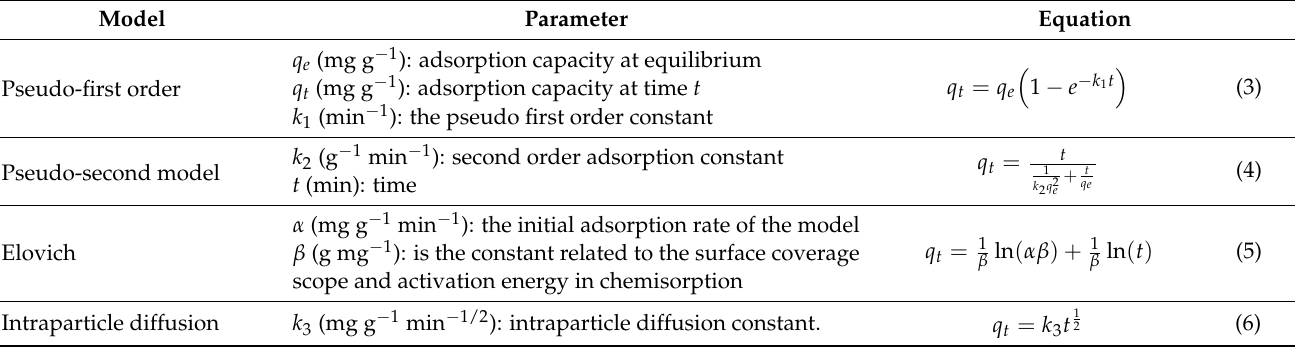
Table 2. Non-linear kinetic models.